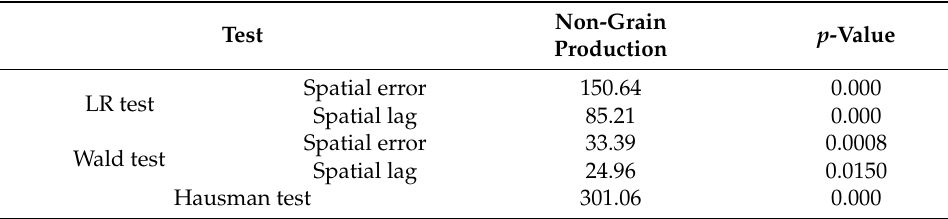
Table 5. LR, Wald, and Hausman